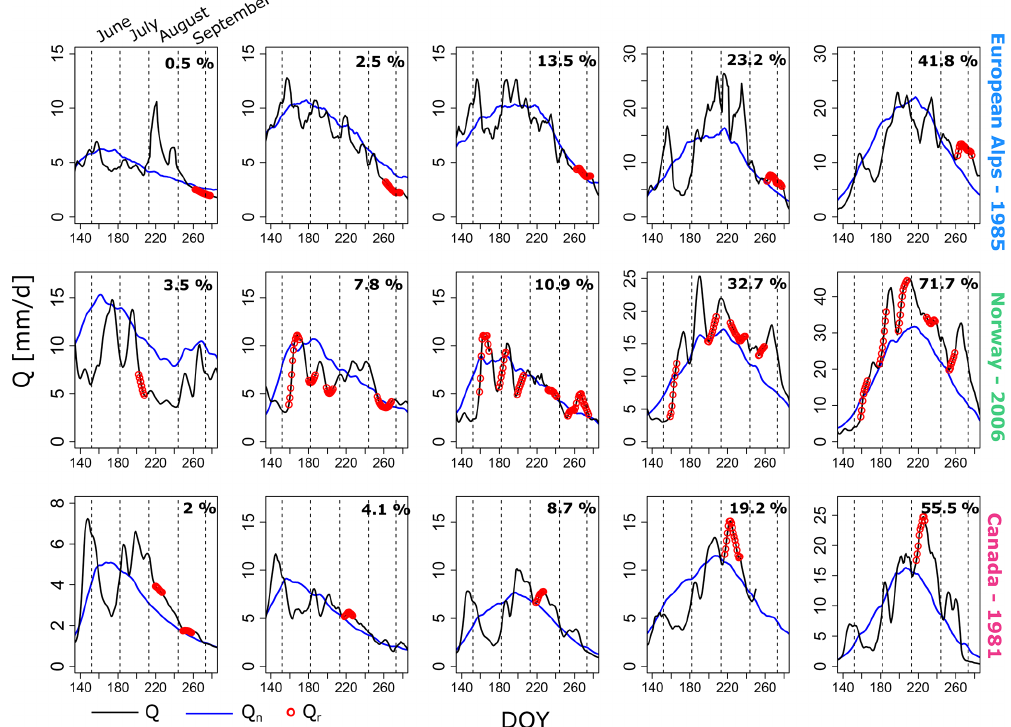
Figure 3. Examples of streamflow responses ( Q r in red) to WD events in different catchments and in different months. Each row represents one region and one specific year. The columns are different catchments, which are sorted from low to high relative glacier cover (left to right). Relative glacier cover of the catchments is indicated in the top right corner. The black line shows the 7d smoothed streamflow in the summer of the respective year, and the blue line shows the long-term daily regime. Note the different y axis for some of the